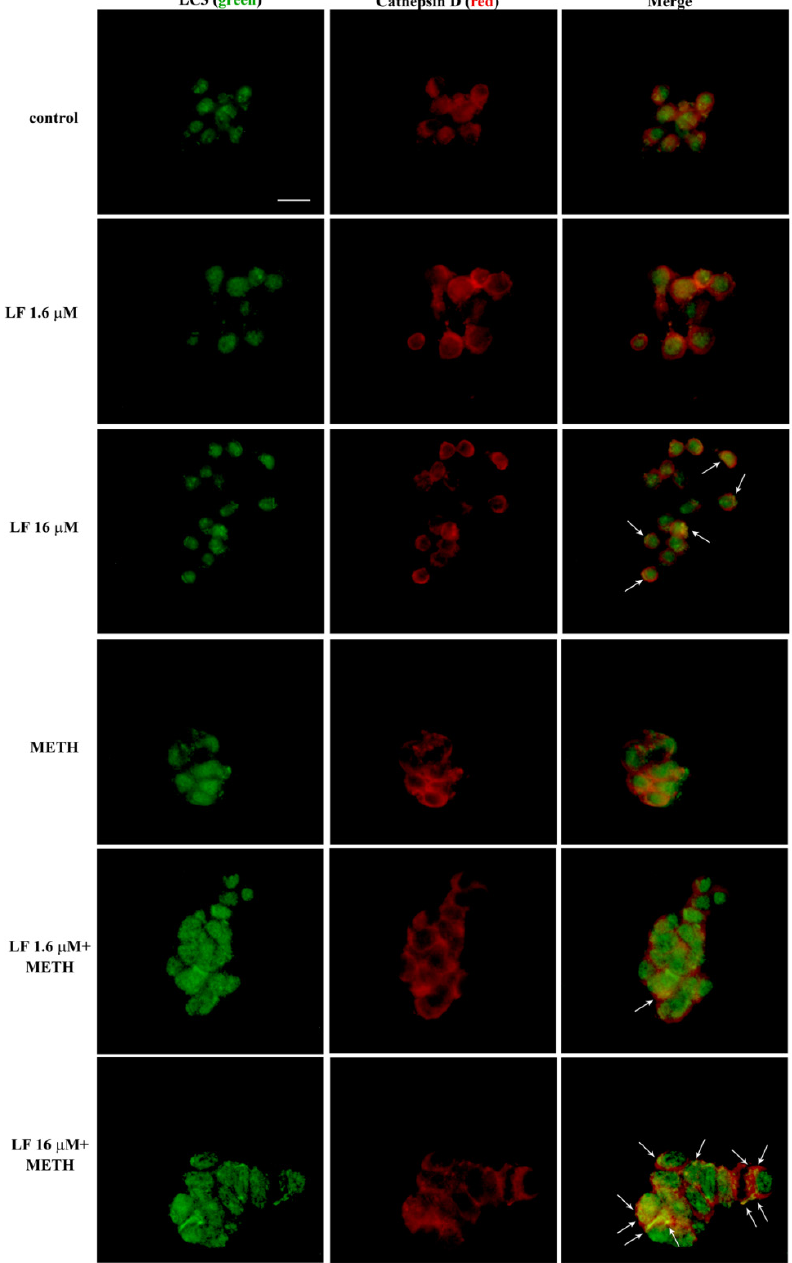
Figure 13. LF increases LC3 and Cathepsin D co-localization. Representative pictures showing double immuno-fluorescence for LC3 (green) and Cathepsin D (red), and their merge in combined LF and METH treated cells. Arrows indicate cells with intensely merged fluorescence resulting in yellow puncta. Scale bar = 15 μ M.